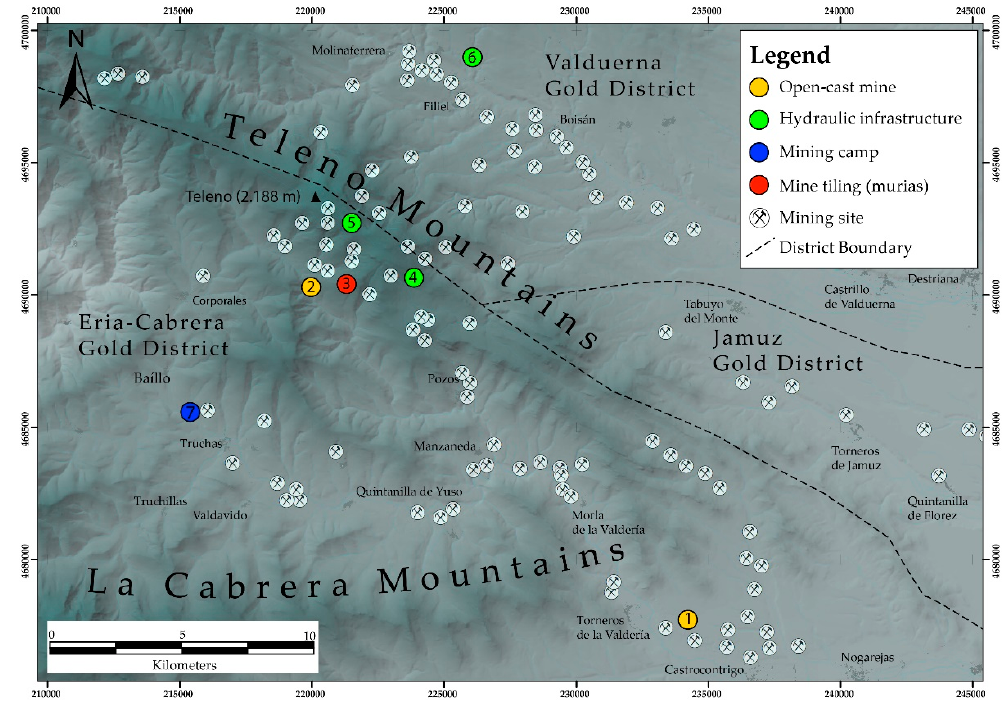
Figure 2. Distribution of Roman mining sites in the Teleno Mountains and its surroundings and location of study elements comprising open-cast mines and tailing deposits, hydraulic infrastructure, and a mining camp. Numbers: 1, Model 1; 2, Model 2; 3, Model 3; 4, Model 4; 5, Model 5; 6, Model 6 and 7, Model 7.